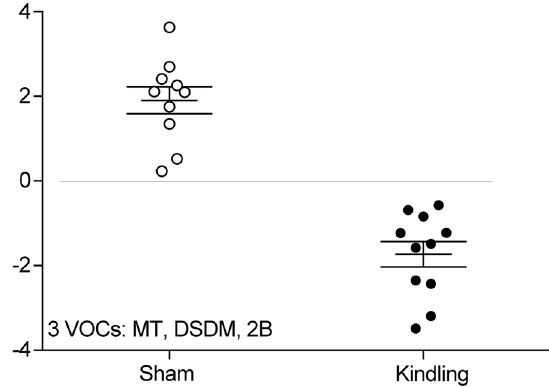
Figure 4. Scatter diagram of the stepwise linear discriminant analysis for determining VOCs associated with kindled seizures. Stepwise linear discriminant analysis with Wilk’s lambda was applied to the thirteen VOCs. F-value probabilities less than 0.05 led to retention and greater than 0.10 to deletion. The standardized canonical discriminant function coefficients were 0.772 (methanethiol), − 0.882 (2-butanone), and 0.677 (disulfide, dimethyl) (eigenvalue, 3.650; canonical correlation, 0.886; Wilks’ lambda, 0.215; chi squared, 26.897, df (degrees of freedom), 3, p =